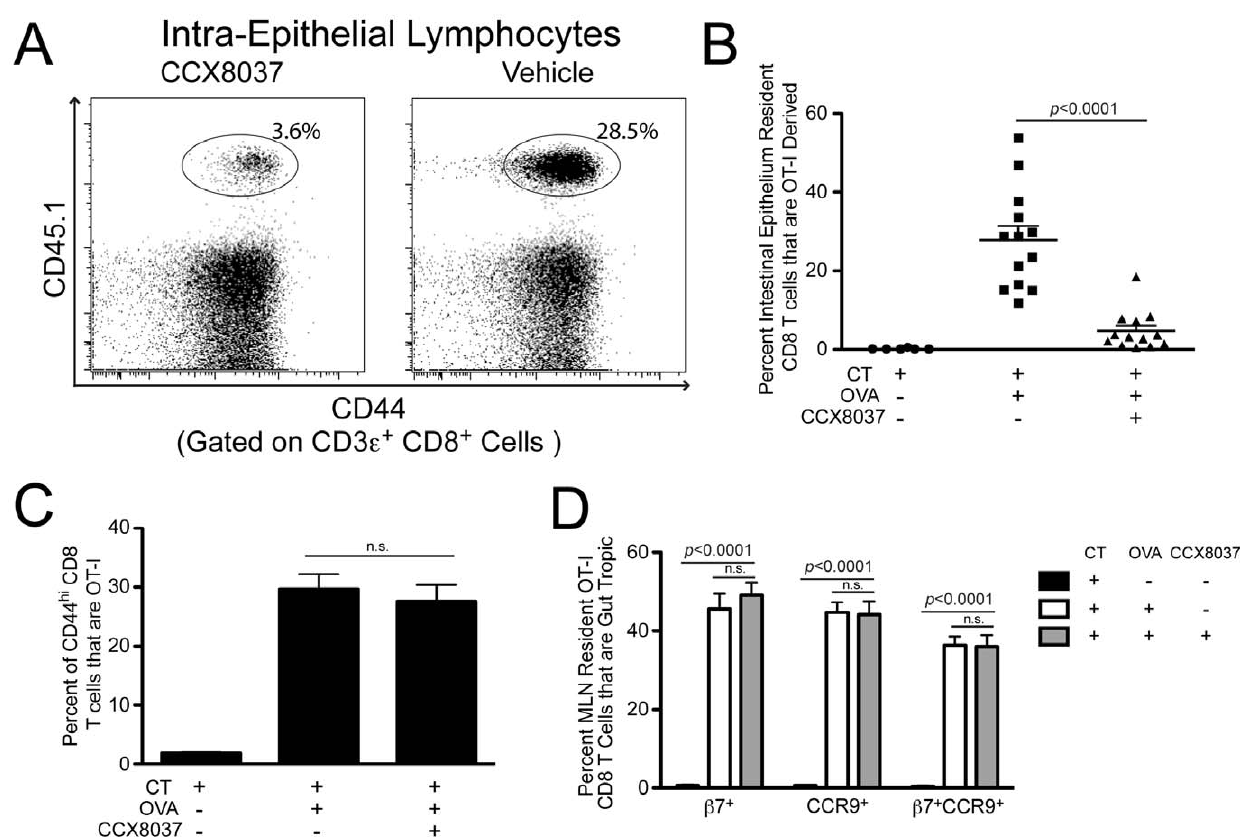
Figure 2. CCX8037 reduces accumulation of OT-I CD8 T cells in the intestinal epithelium without affecting gut homing tropism, imprinting and proliferation. Animals were injected with 3e6 OT-I CD8 T cells, and immunized 24 hours via oral gavage with either 10 m g Cholera Toxin (CT) only, or CT + 25 mg Ovalbumin (OVA). Animals given OVA were also injected subcut. every 12 hours for the course of the study with CCX8037 (30 mg/kg) or vehicle. Mice were sacrificed for analysis 5 days post immunization. Mean and SEM shown for each data point, p values indicate Bonferroni multiple comparison post test. (A) Representative flow cytometry plot showing the accumulation of CD44 hi CD8 T cells, and gating of OT-I (CD45.1) cells in the intestinal epithelium. Plots are pre-gated on CD3 e + /CD8 a + cells. (B) Quantification of OT-I CD8 T cell